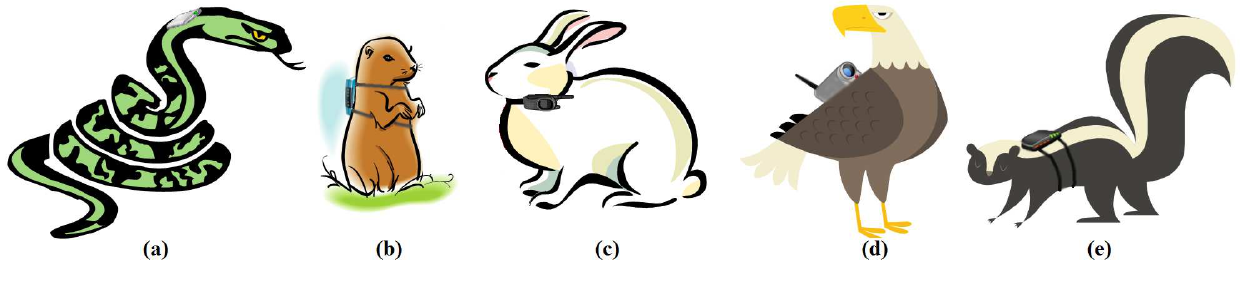
Figure 1. Some animals that can be used as MBS in the